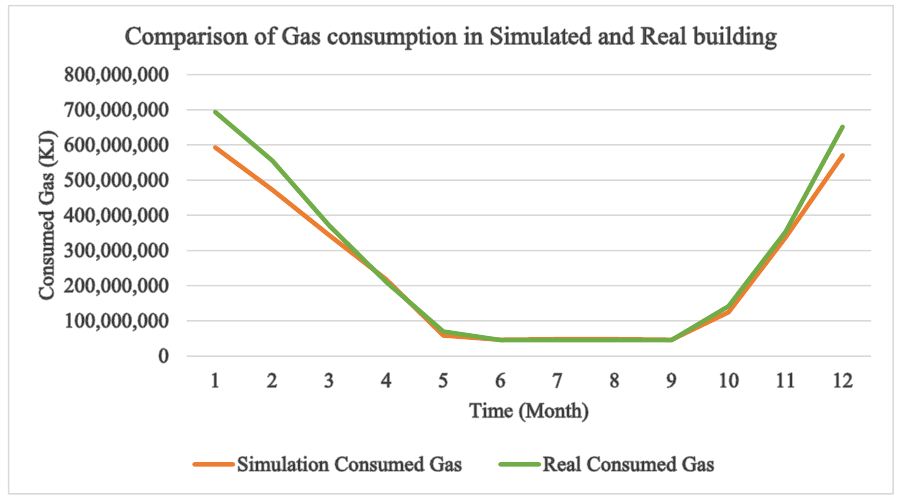
Figure 5. Annual Consumed Gas of Real Building and Simulation.